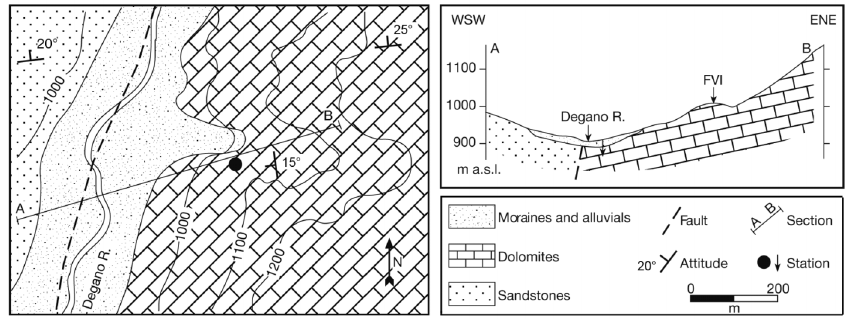
Fig. 7. Geological map and section at the site of the station FVI (Forni Avoltri). Contour topography isobaths is also